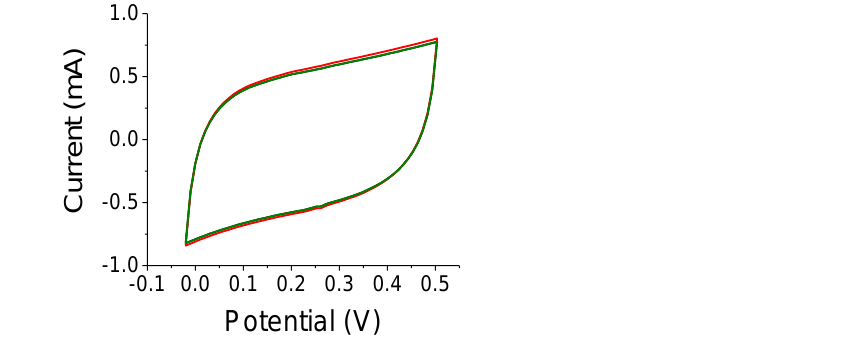
Figure 8. C-V curves for S-C without TiO 2 colloids for an OFF, ON, OFF cycle. The scan rate was 0.1 V/s.